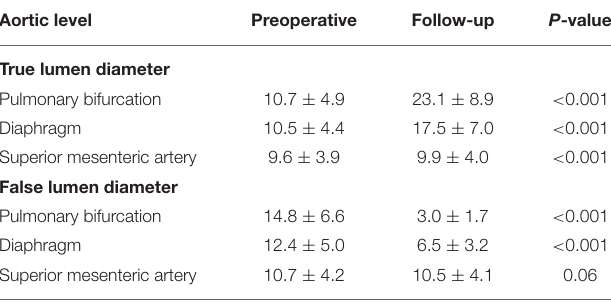
TABLE 4 | Comparison preoperative and follow-up diameters (mm ±